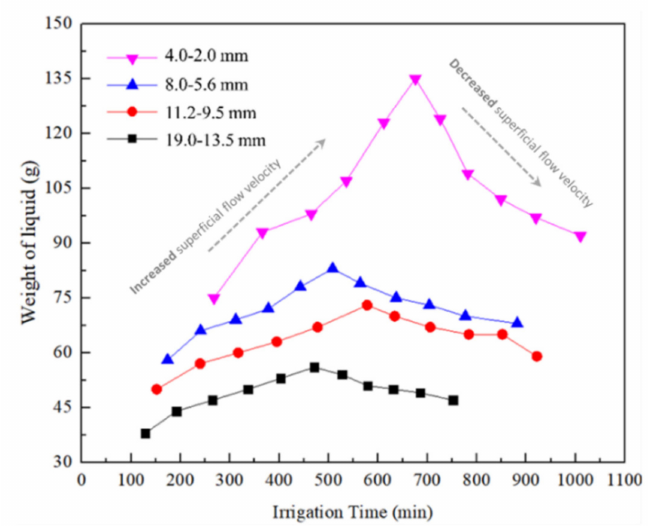
Figure 4. Relationship between irrigation time and weight of liquid